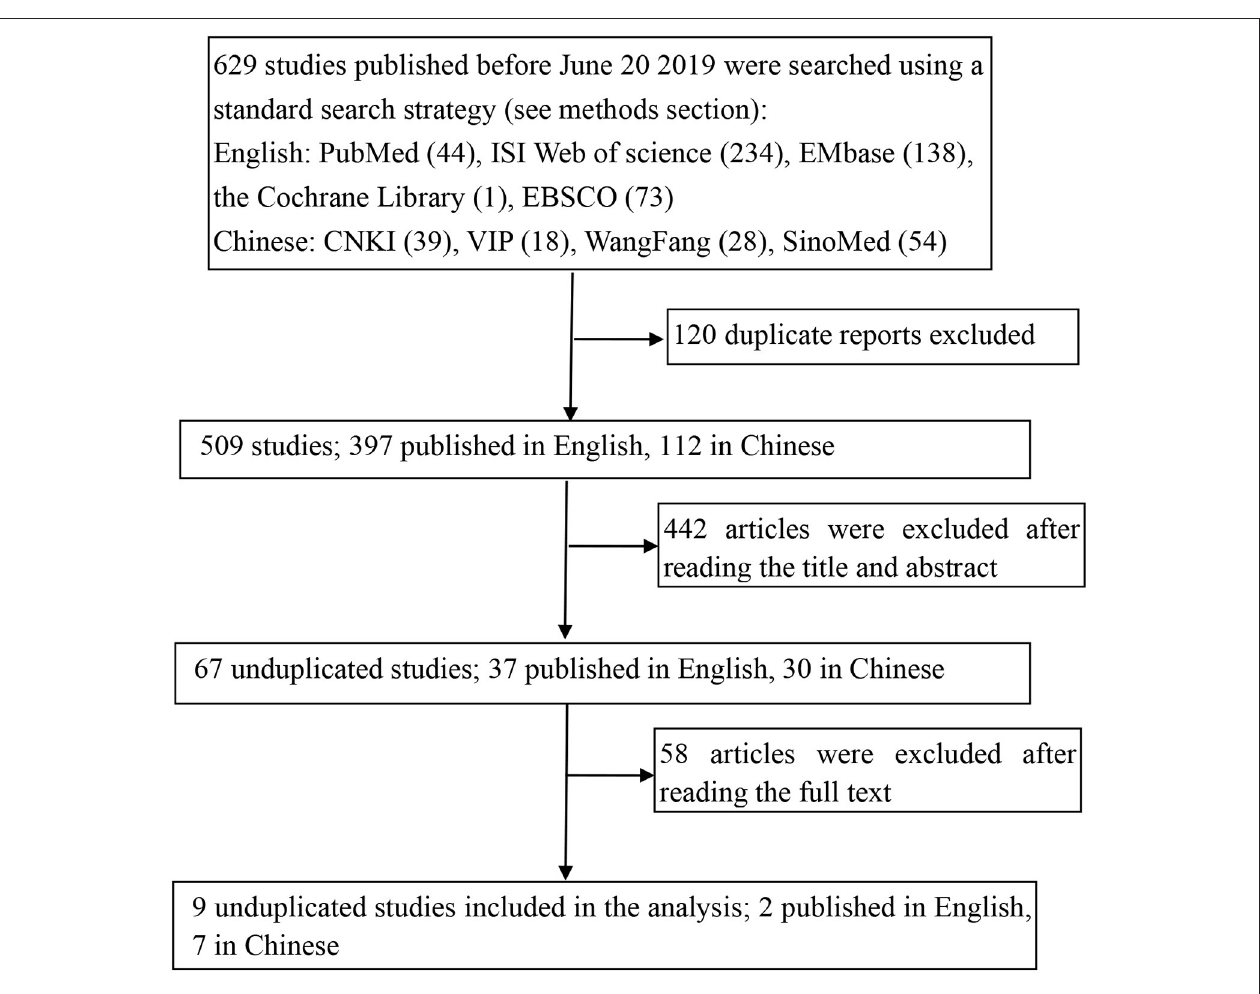
FIGURE 1 | Flowchart of the literature search and screening